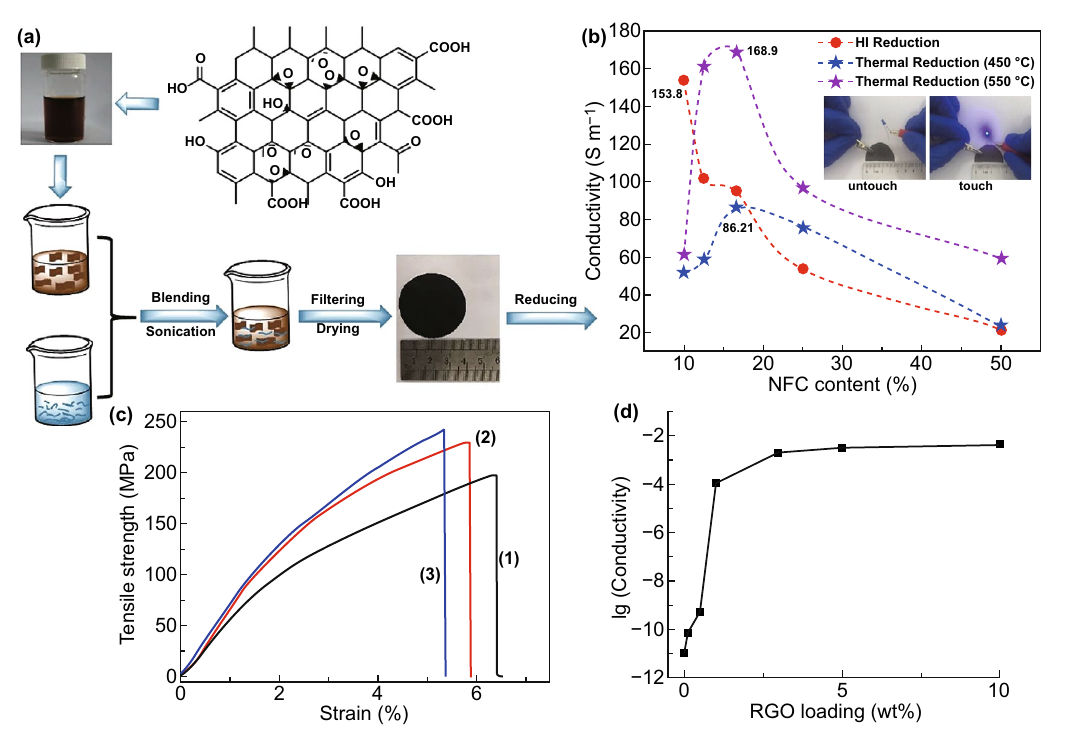
Fig. 13 a Schematic view of the synthesizing, functionalization, and fabrication process of CNFs-GO/rGO hybrid nanocomposite film. b Influ- ence of green GO chemical and thermal reduction and CNFs content on the electrical conductivity of CNFs-rGO hybrid film. Reproduced with permission from Ref. [37] Copyright © 2020, Springer. c Stress–strain curves of (1) BNCs, (2) GO, and (3) BNCs-GO hybrid nanocomposites films. d Electrical conductivity of BNCs-rGO hybrid film. Reproduced with permission from Ref. [142] Copyright © 2011, Elsevier